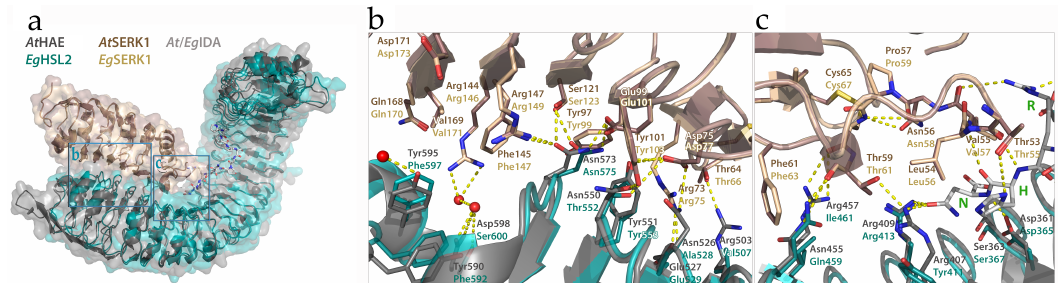
Figure 5. Structural alignment of the of A. thaliana HAE-IDA-SERK1 crystal complex (PDBid:5iyx) and the E. guineensis HSL2-IDA-SERK1 model complex. ( a ) Overall alignment of the two structures in cartoon and surface representation, with IDA shown as sticks. ( b ) Alignment of the hydrogen bonding network in the HAE / HSL2-SERK1 core interface and ( c ) in the HAE / HSL2-IDA-SERK1 interface in both complexes. Central amino acids, as well as the IDA peptides, are shown as sticks and colored by atom type. Water molecules are shown as red spheres. Hydrogen bonds are depicted as dotted lines